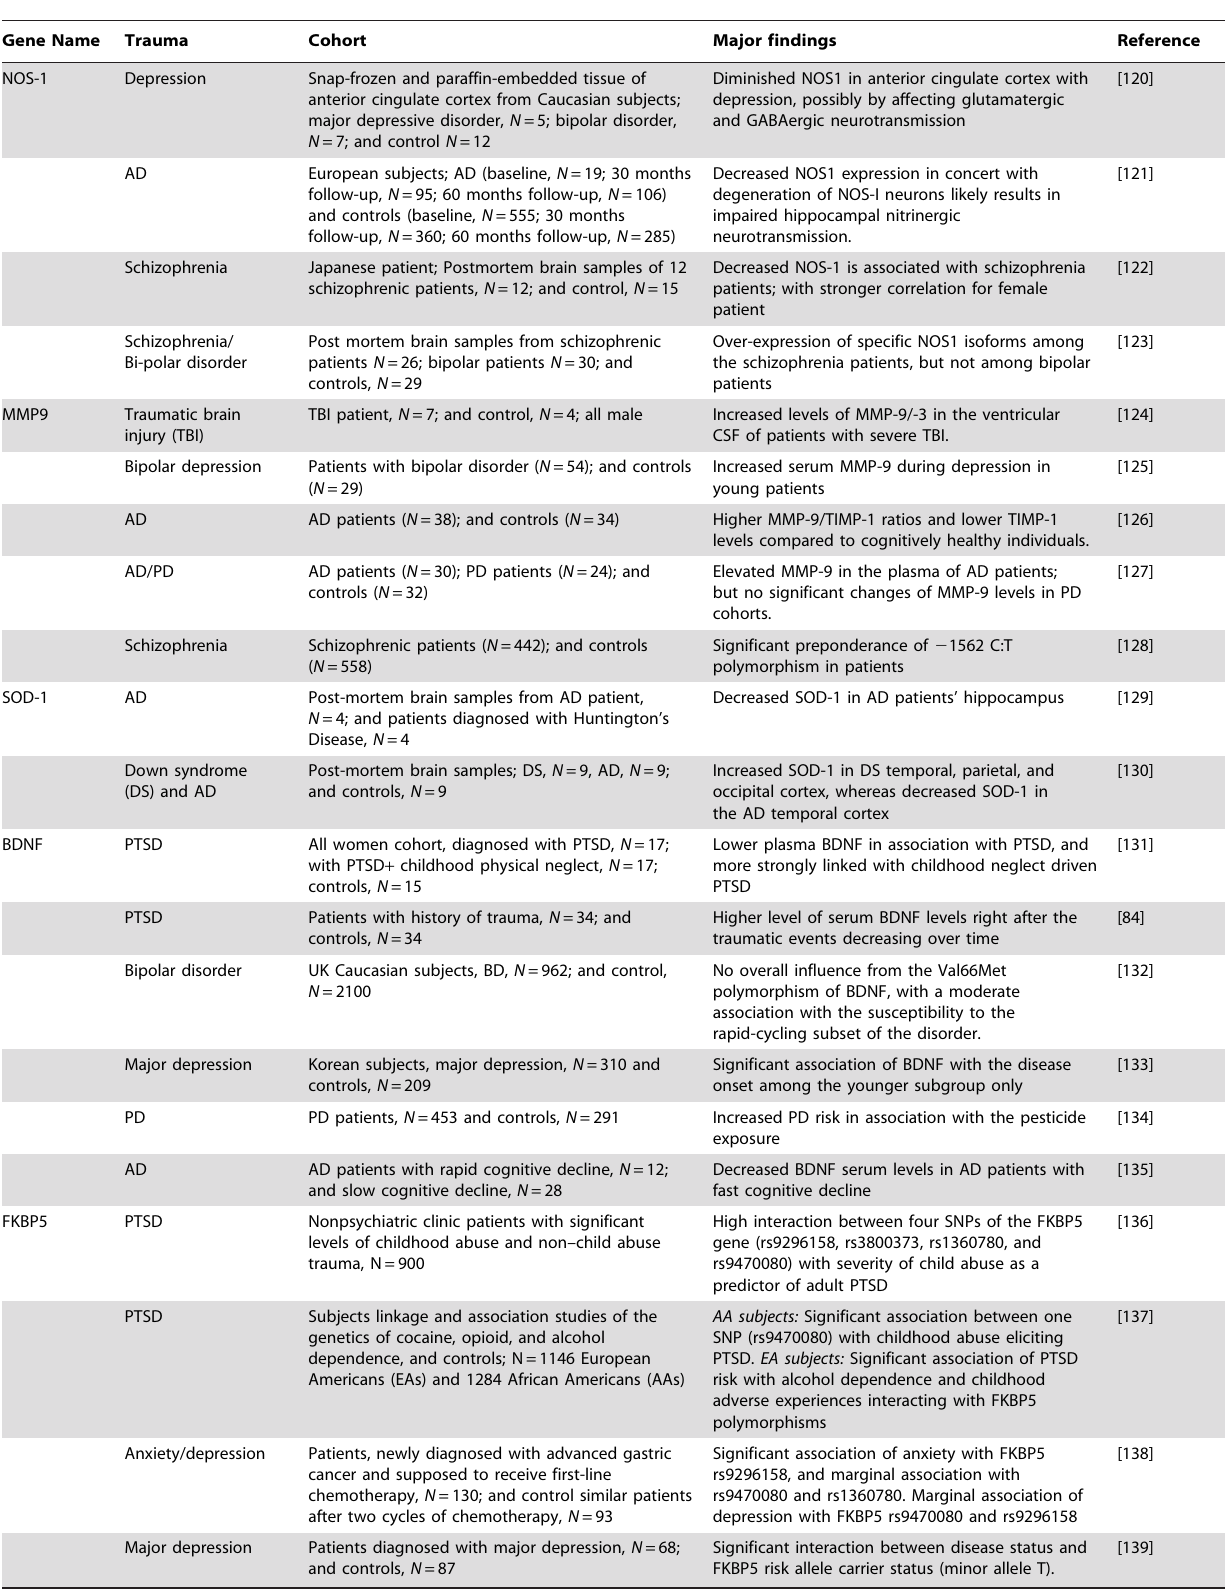
Table 2. A brief literature survey of clinical studies associated with the panel of genes validated by